Question: In a single sentence, describe what this figure presents.
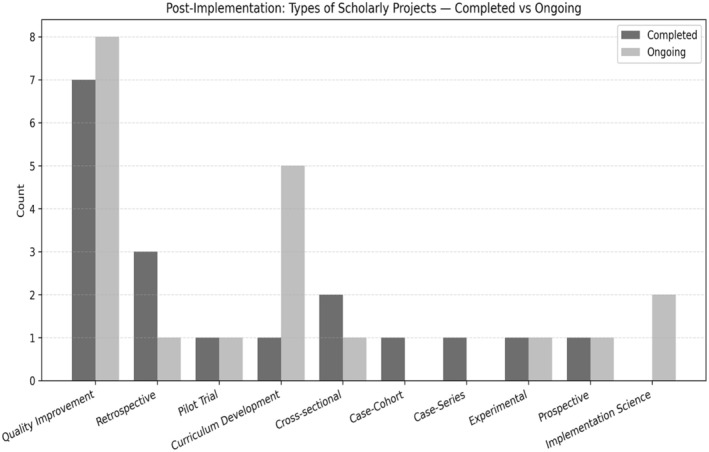
Answer: Eighteen projects were completed, while 20 initiatives remained ongoing at the time of analysis. Ongoing projects were at various stages of development, including data collection, IRB submission, protocol drafting, and data analysis. Quality improvement and curriculum development projects were the leading initiatives needing the most support from the faculty scholarship program.